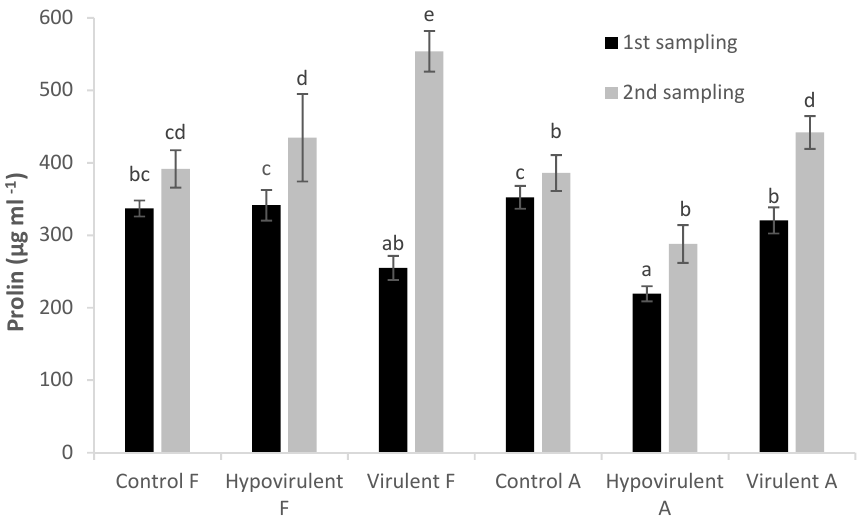
Figure 7. Proline content in leaves 21 and 42 days after infection. Values are means ± SD, n = 5. Significant differences among samples based on the Tukey-HSD test.